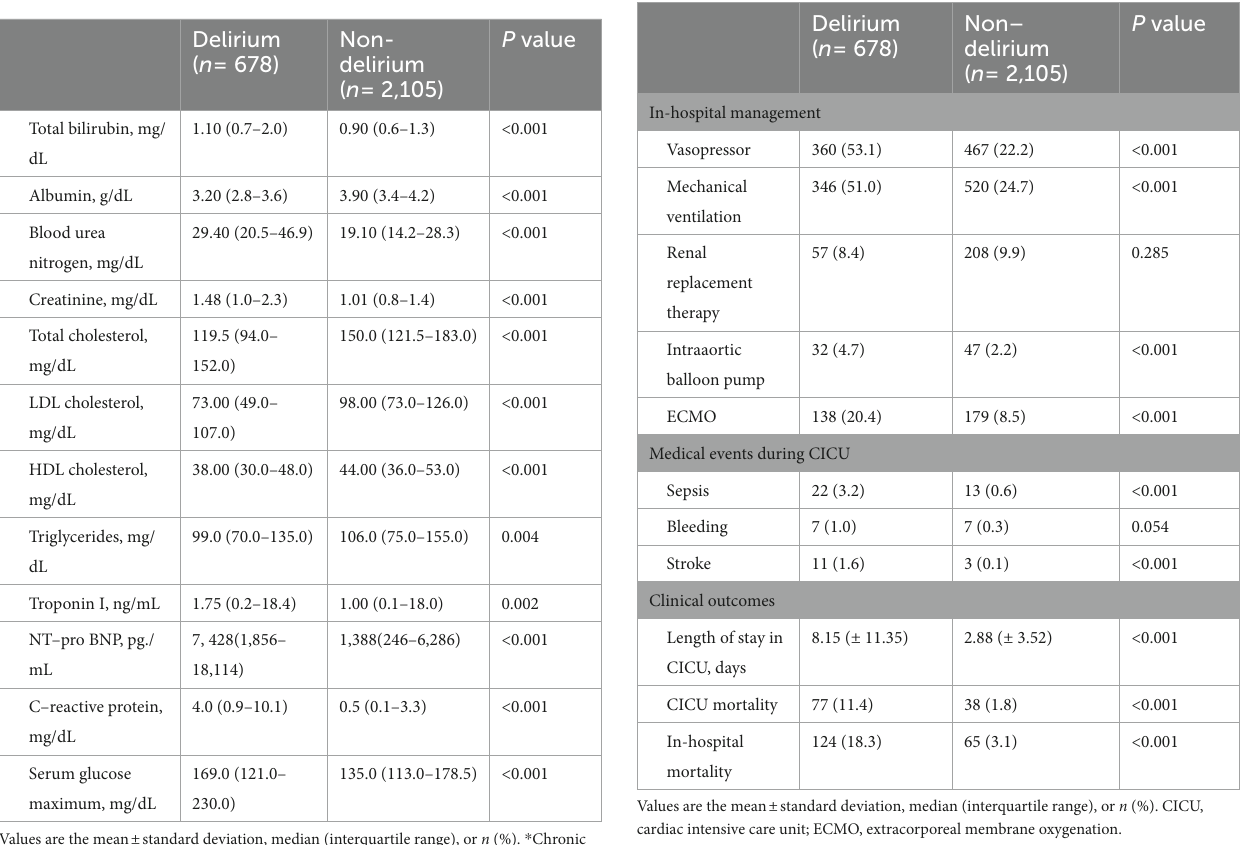
TABLE 2 In-hospital management and clinical